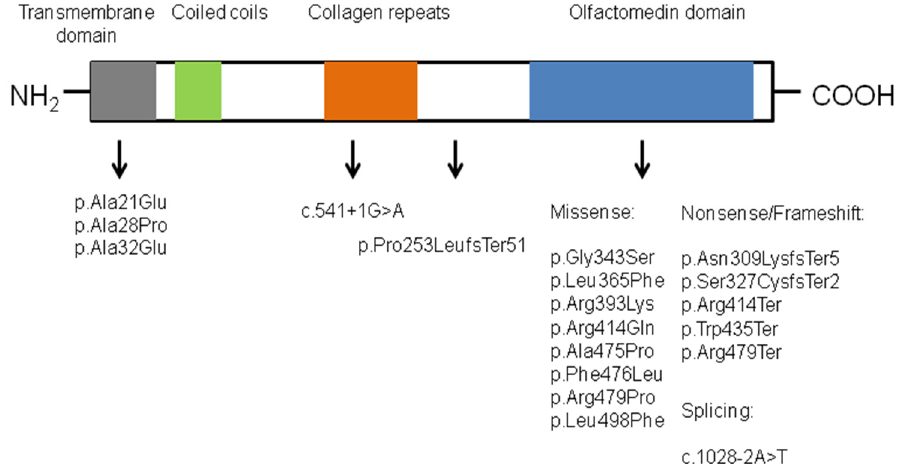
Figure 3. Location of the pathogenic/likely pathogenic variants identified in GLDN in AMC-affected families relative to the predicted protein domains. Table 1. Clinical characteristics of cases with biallelic GLDN variants and arthrogryposis multiplex congenita (AMC).